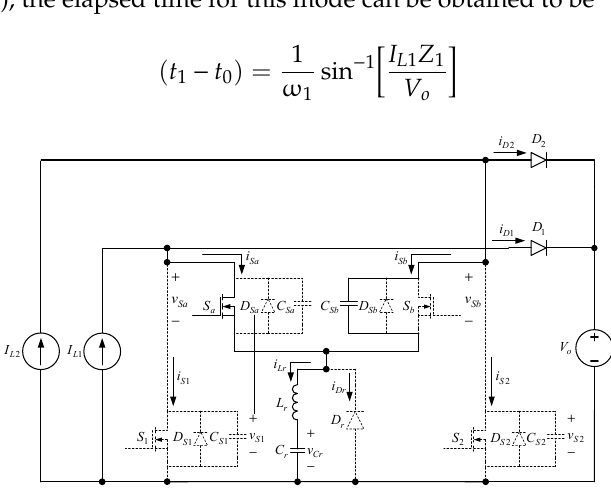
Figure 4. Current path in mode 1.